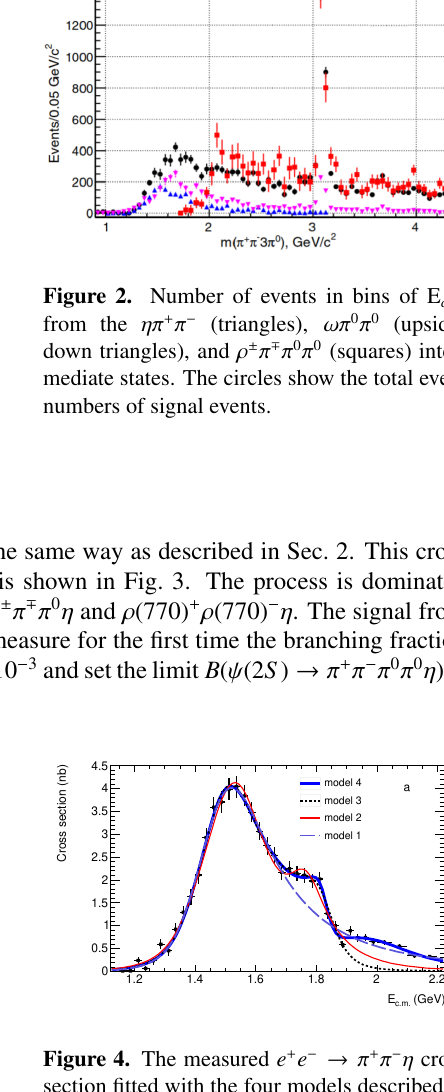
Figure 3. The measured e + e − → π + π − π 0 π 0 η cross section. The uncertainties are statistical only.